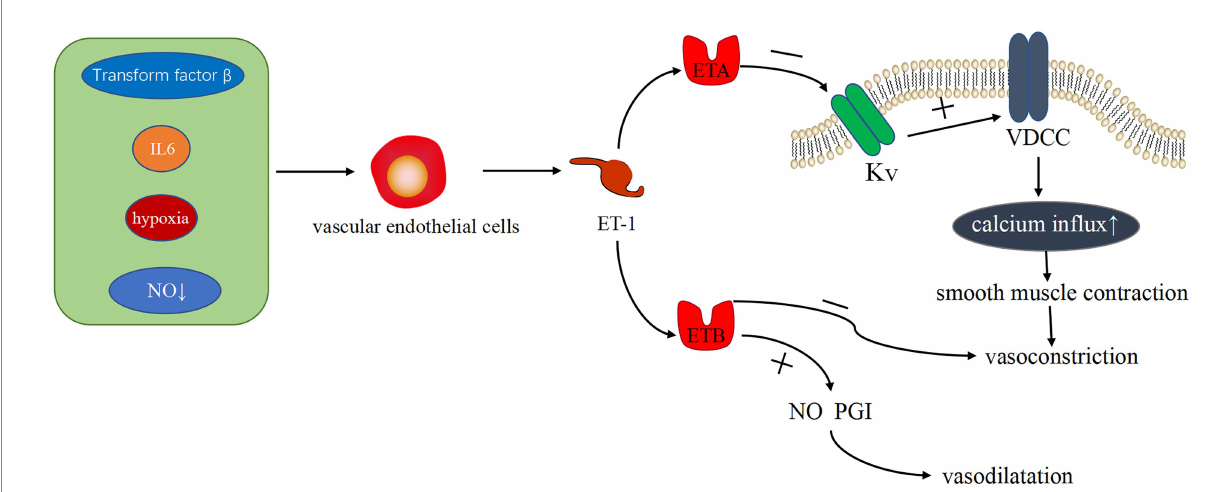
FIGURE 1 Related pathways of ET-1 vasoconstriction. Transforming factor- β , IL-6, hypoxia, and NO reduction can stimulate endothelial cells to produce ET-1. The binding of ET-1 and ET-1A receptor protein can inhibit the K + channel, activate Ca 2+ channel, increase Ca 2+ influx, and cause vasoconstriction. ET-1 binding to ET-1B receptor protein can clear ET-1, inhibit vasoconstriction, and promote the production of vasodilator substances, such as NO and PGI, causing